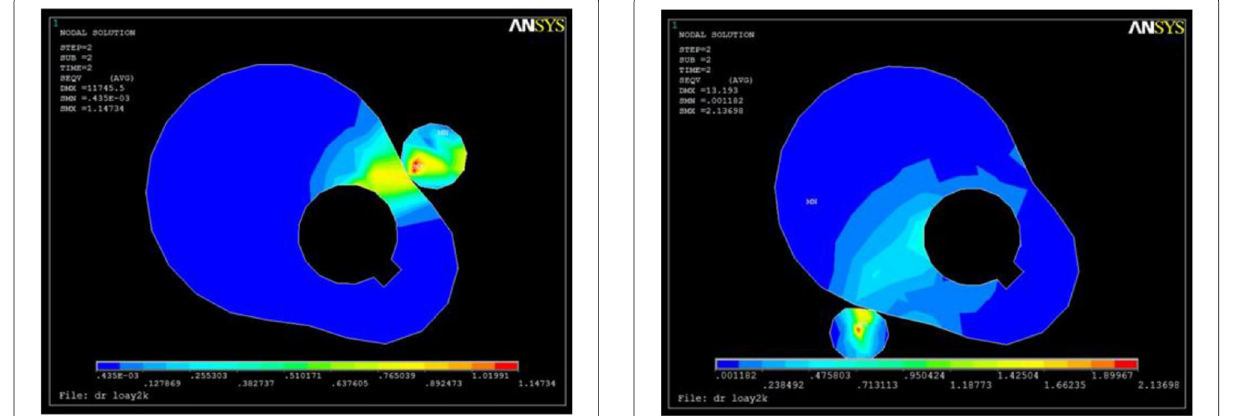
Figure 24 Contact stress contour when the follower located at 270° with the